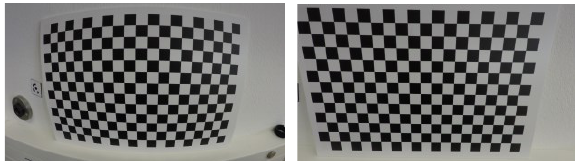
Figure 7: Distorted and undistorted image